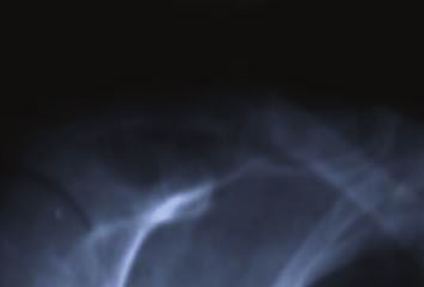
Figure 3: Histopathology slide showing brown tumour of hyper- parathyroidism (multiple osteoclasts in a fibrous network); H & E stain, × 100 magnification.